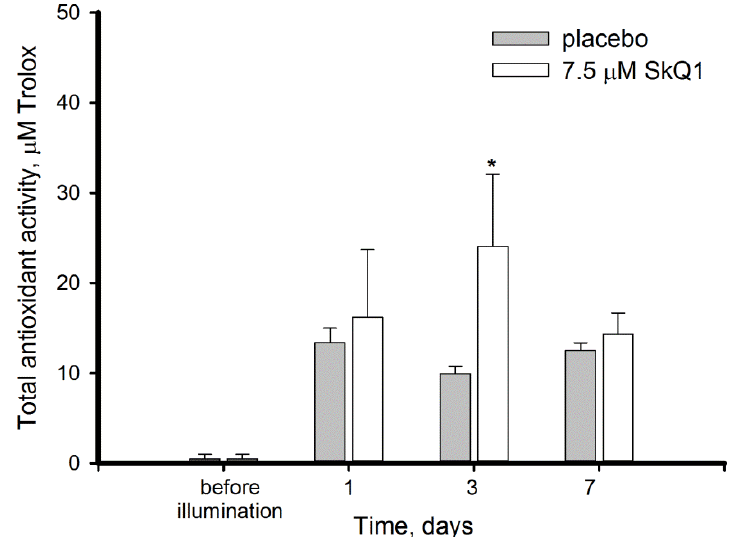
Figure 4. Total antioxidant activity (AOA) in extracts of intact and illuminated rabbit retinas with or without premedication with 7.5 μM SkQ1. AOA was determined by hemoglobin/H 2 O 2 /luminol assay. Each bar represents the data obtained from six animals (12 eyes). * p ≤ 0.05 compared with the values measured in the control animals.